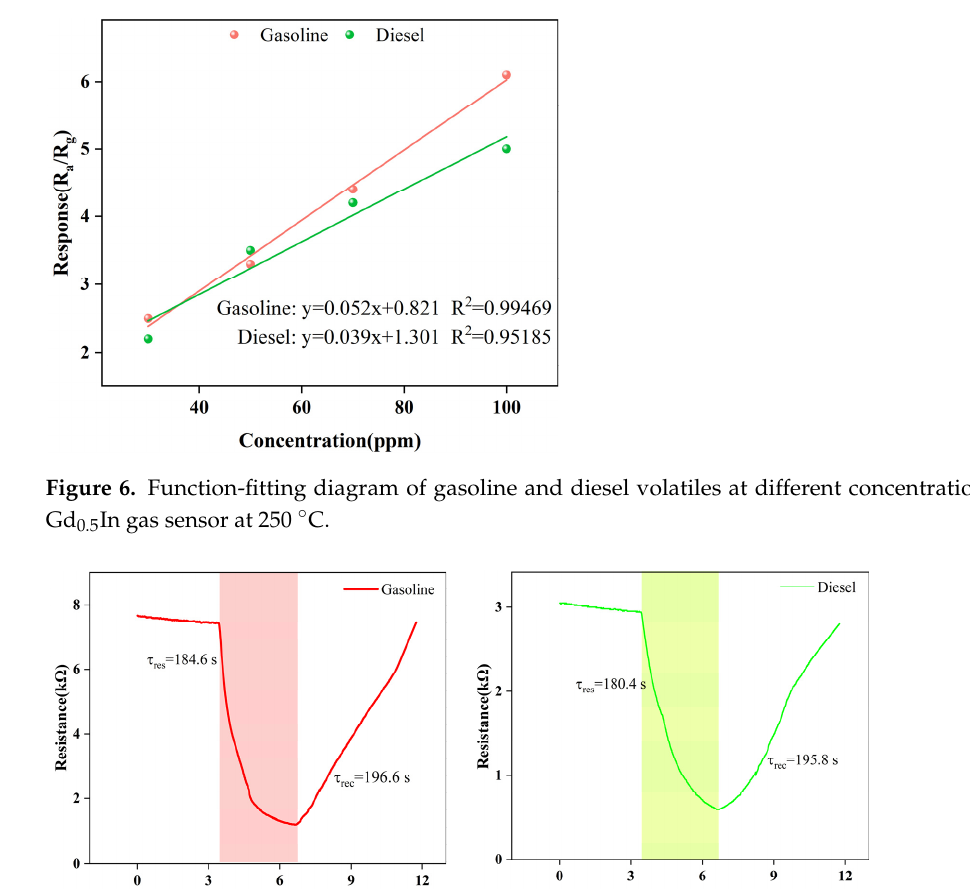
Figure 7. Recovery characteristics of Gd 0 . 5 In response to 100 ppm gasoline and diesel volatiles at 250 ° C. ( a ) Gasoline; ( b ) diesel.